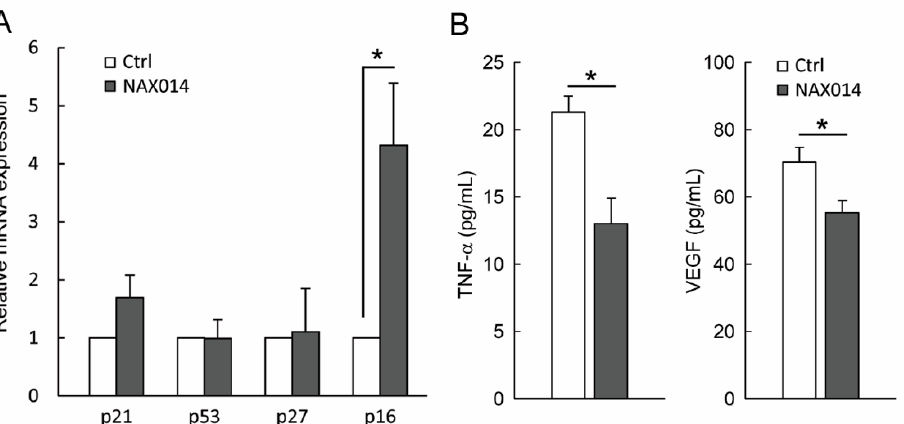
Figure 3. Effect of NAX014 on p21 , p53 , p27 and p16 expression in mammary tumor samples and on plasma levels of TNF- α and VEGF. ( A ) Relative p21 , p53 , p27 and p16 mRNAs expression has been analyzed by real time-PCR. mRNA levels are expressed as fold change (ratio of target:reference gene) * p ≤ 0.05 versus control values. ( B ) TNF- α and VEGF plasma levels were quantified using ELISA kit. Data are reported as means ± SD. * p ≤ 0.05 versus control values.